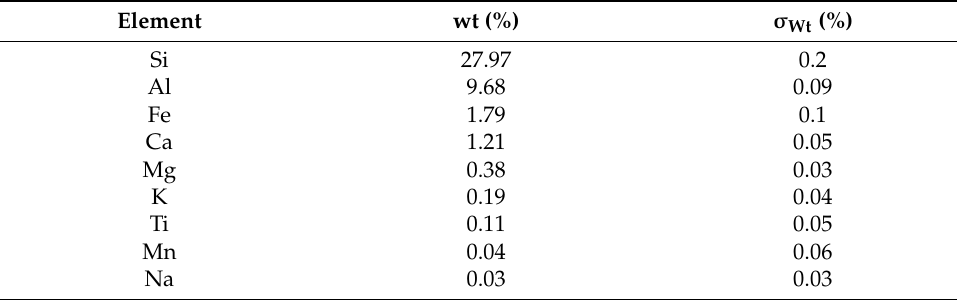
Table 7. Major elements determined by